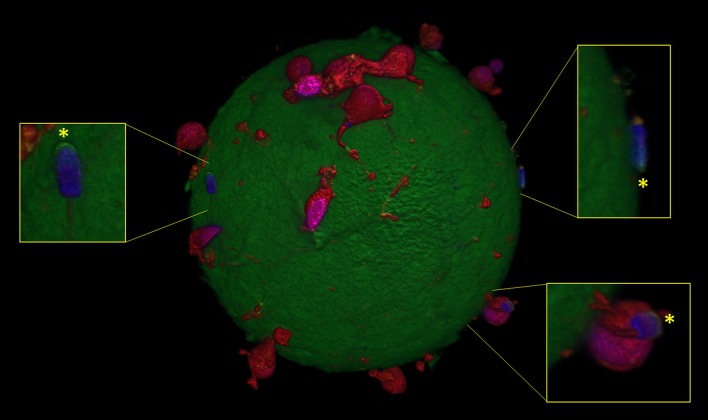
Confocal microscopy image showing spermatozoa with intact spermatozoa (*) adherent to oocyte zona pellucida, in presence of Aminopurvalanol A.